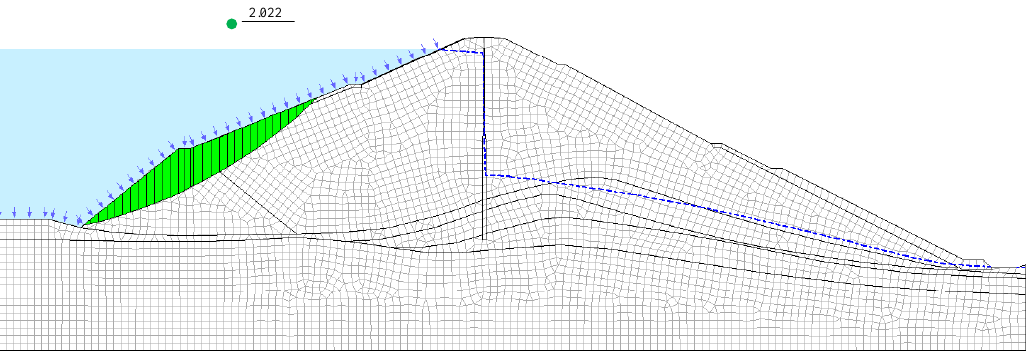
Figure 3. The most dangerous sliding surface of upstream dam slope before sudden drop of water level.